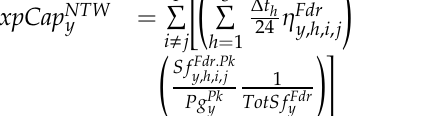
Table 1. Indices calculated for the validation test in the case 1 .